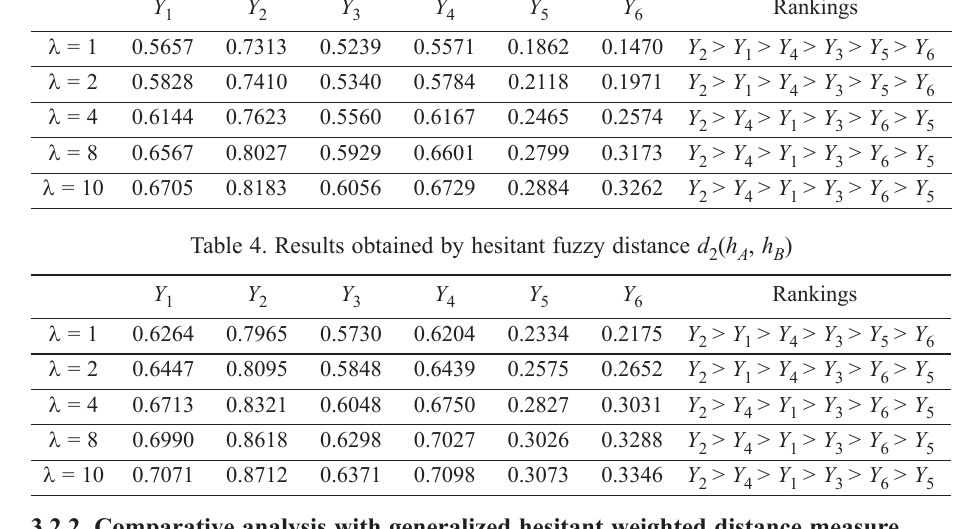
Table 3. Results obtained by hesitant fuzzy distance d Y Y 1 2